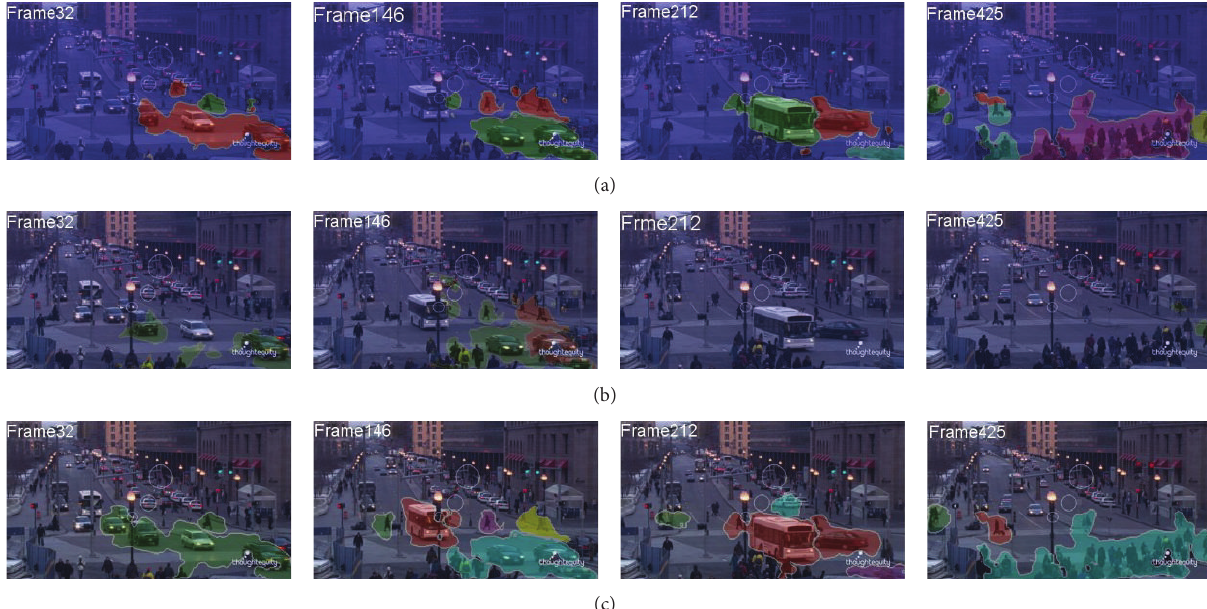
Figure 4: Comparison of segmentation results by using proposed method (1st row) and proposedNC (2nd row) and SRF (3rd